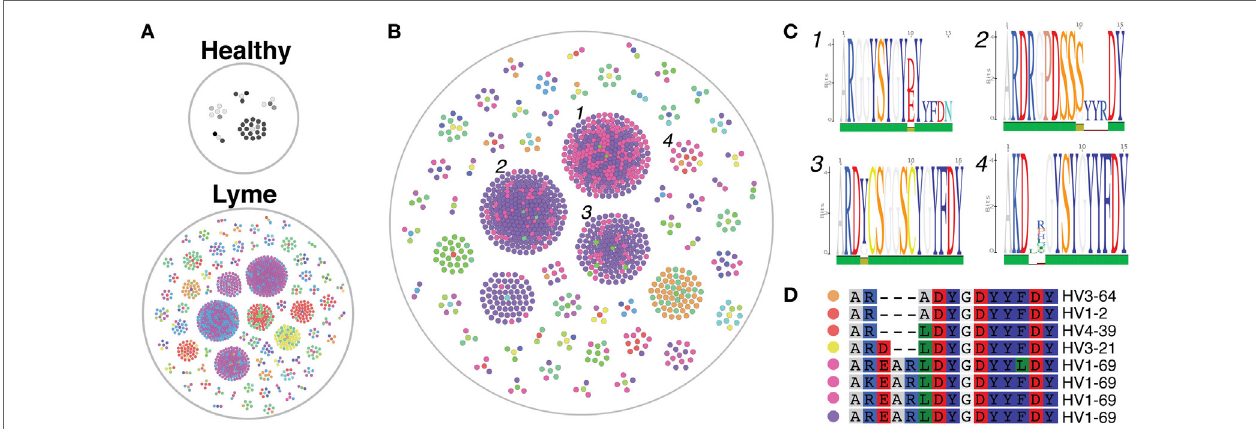
FigUre 6 | Heavy-chain immunoglobulin sequencing of bulk mRNA from peripheral blood mononuclear cells (PMBCs) derived from untreated Bb- infected patients reveals disease-specific CDR3 sequence motifs. Bulk heavy-chain CDR3 sequences from PMBCs of untreated Lyme disease patients and healthy controls were clustered using the cd-hit algorithm to identify convergent sequence motifs. A total of 379,457 full-length error-corrected VDJ sequences were included in the analysis. Each dot represents a sequenced antibody clone, with colors representing individual subjects. (a) Clusters were filtered based on those containing at least three separate subjects, and the size and number of these convergent clusters visualized using the igraph package in R. Healthy controls revealed only five cross-patient clusters, while numerous convergent clusters were revealed untreated Lyme disease patients. (B,c) Convergent clusters present in at least three separate Lyme subjects (B) , but not present in any healthy controls were visualized using igraph, and individual sequences from four clusters with multiple subjects were aligned to display specific sequence motifs (c) . (D) Sequence alignment of cluster 4, which includes five separate Bb- infected patients, including the predicted V gene used by each clone. Colored dots correspond to matching subjects in panel (B)